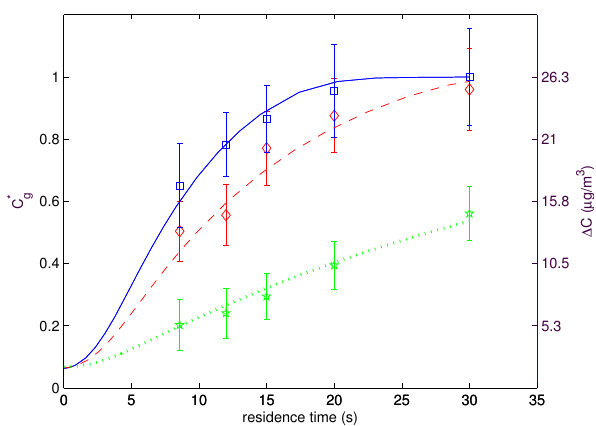
0 5 10 Fig. 2. Measured particle mass changes and dimensionless vapor build-up profiles for adipic acid aerosol in a TD. T in =25 ◦ C and T w =40 ◦ C. Blue squares and solid: C 0 =390µgm − 3 , N tot =10 12 particlesm − 3 , d p , cs =65nm; red diamonds and broken: C 0 =245µgm − 3 , N tot =6 × 10 11 particlesm − 3 , d p , cs =65nm; green stars and dotted: C 0 =68µgm − 3 , N tot =2.5 × 10 11 particlesm − 3 , d p , cs =60nm. The lines show model simulations of C ∗ g